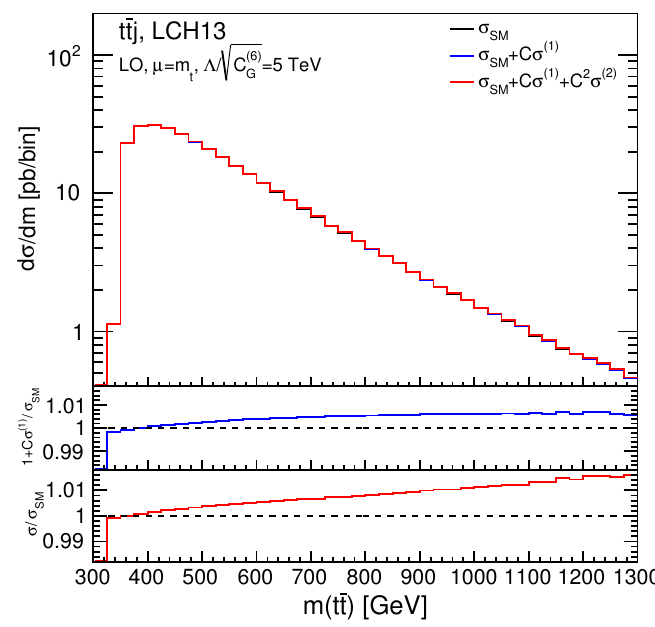
Figure 10 . Invariant mass of a pair of top quarks produced in association with a jet at LHC13, for the SM and including at most one insertion of the O G operator in the production amplitudes ( O (1 = (cid:3) 2 ) and O (1 = (cid:3) 4 ) terms). A transverse momentum cut of p T; min > 50 GeV is applied to the jet produced.